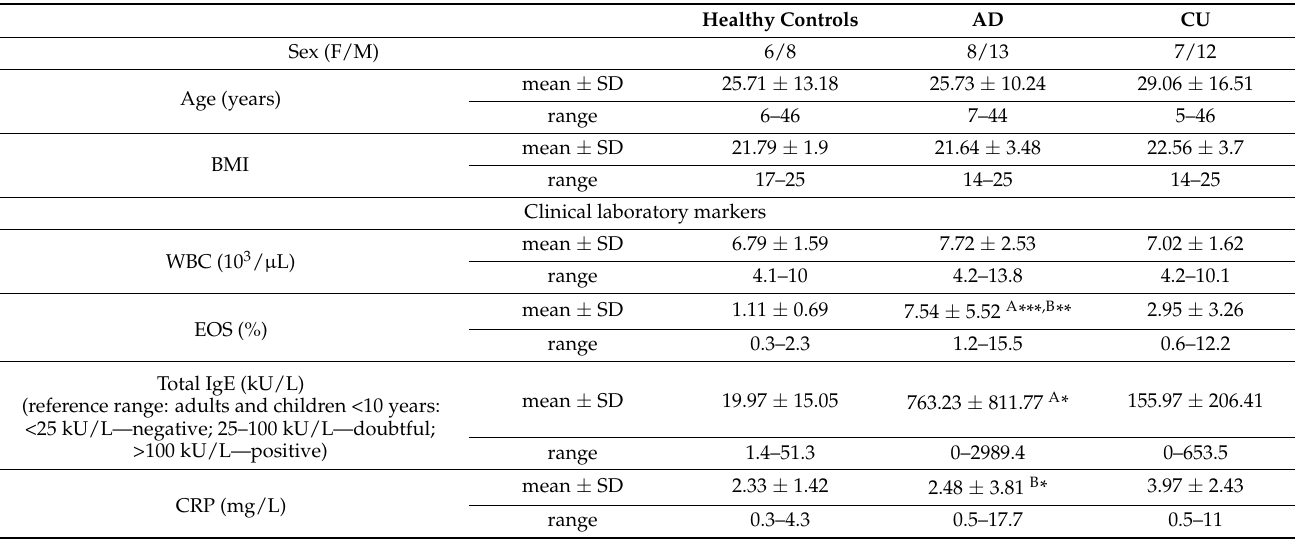
Table 1. Characteristics of patients at enrollment a